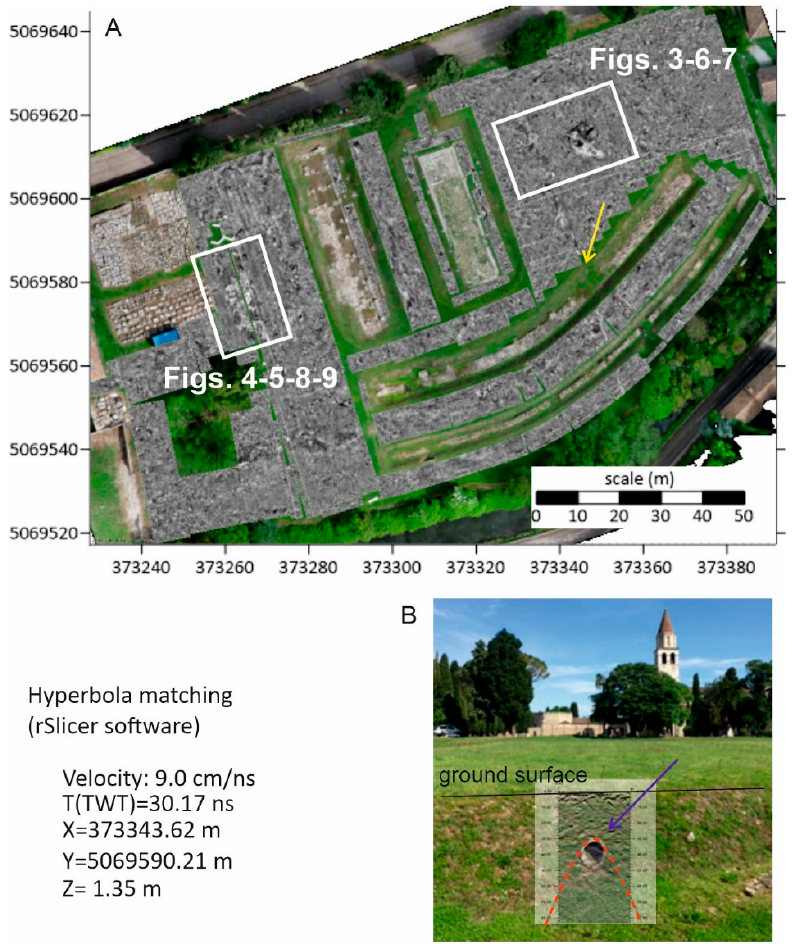
Figure 2. ( A ) Exemplary time-slice of the GPR data volume processed and the location of the areas reported in Figures 3–9; ( B ) Portion of a GPR profile crossing an outcropping pipe (its location is highlighted in A by the yellow arrow) and the result of the hyperbola fitting analysis.